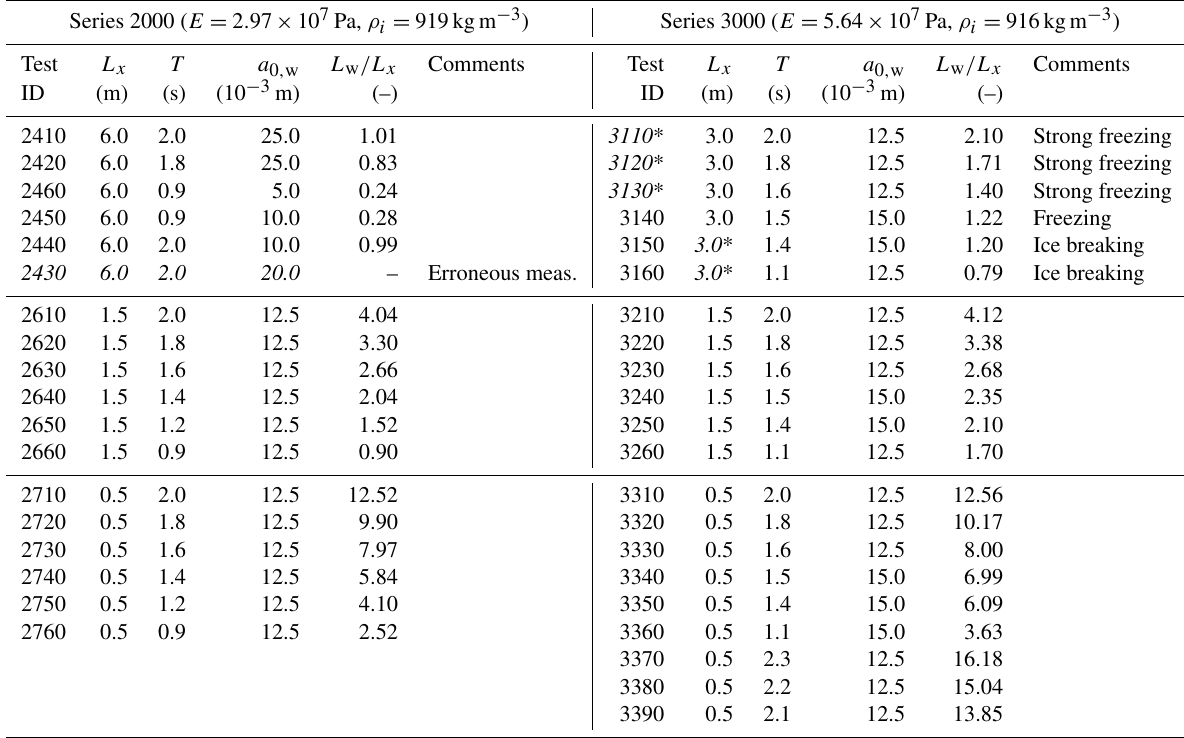
Table 1. Summary of the set-up of experiments in test series 2000 and 3000 (in chronological order). The ratio L w /L x was computed for wavenumbers determined from observations (Fig. 2). See text for comments on entries in italics, marked with a